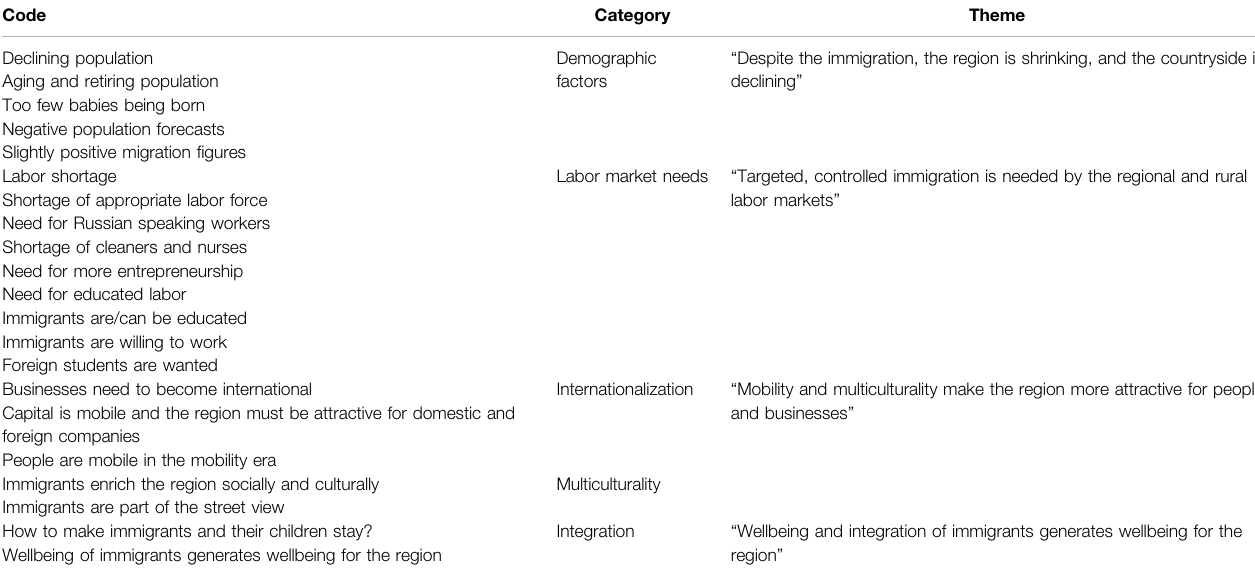
TABLE 1 | The analysis process of comments concerned with the role of immigration in the vitality of North